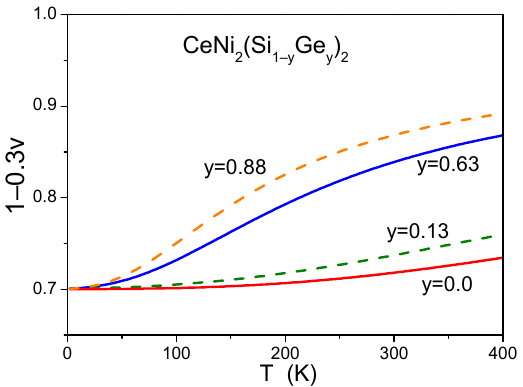
Figure 3. Occupancy of the f states as a function of temperature derived from the thermoelectric power S ( T ) for CeNi 2 (Si 1 − y Ge y ) 2 .